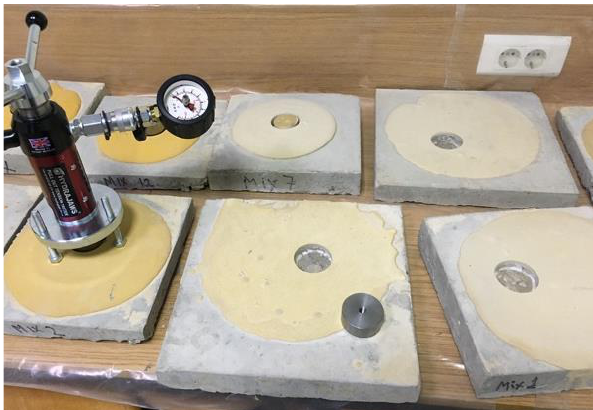
Figure 2. Photo showing the pull-off bond testing set-up.